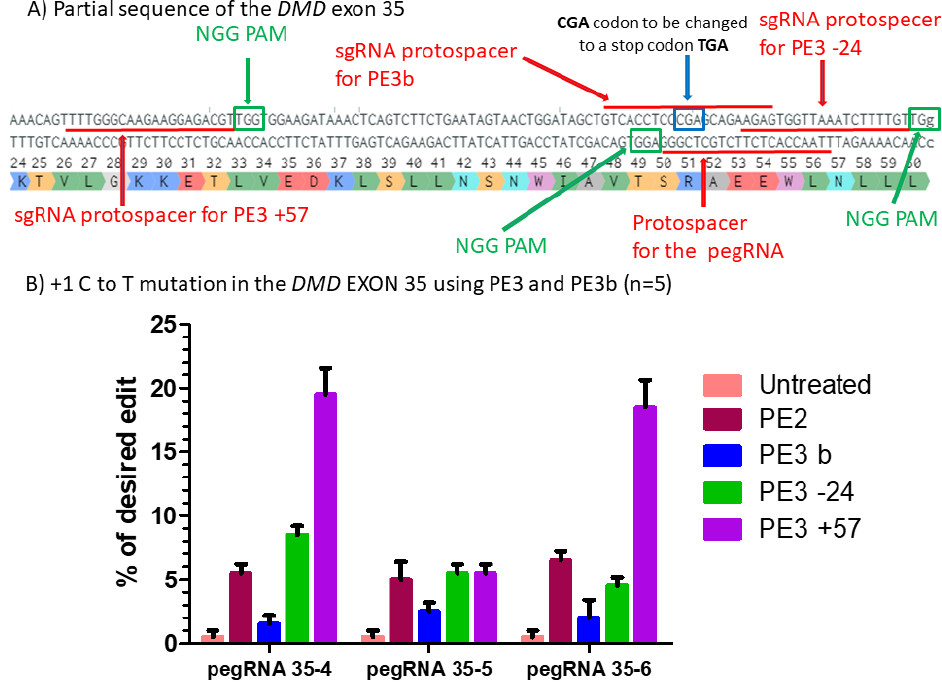
Figure 5. Prime editing of DMD exon 35 using the PE3 and PE3b strategies. ( A ) Partial sequence of exon 35 of the DMD gene including the sgRNA protospacer sequences for PE3. The SpCas9n PAM sequences are in green boxes and the pegRNA protospacer sequences are underlined in red. ( B ) Results of Sanger sequencing and EditR analysis of prime editing of the DMD exon 35 for PE3 and PE3b strategies. There was a 1% background level of thymidine (T) in the position of the targeted nucleotide. However, pegRNA35-4 and pegRNA35-6 showed up to 20% of the desired modification when a second nick was orchestrated at the position +57 from the original nick site. For the three pegRNAs, there was no increase using the PE3b strategy when the second nick was at position -24. These experiments were carried out in five independent replicates ( n = 5).